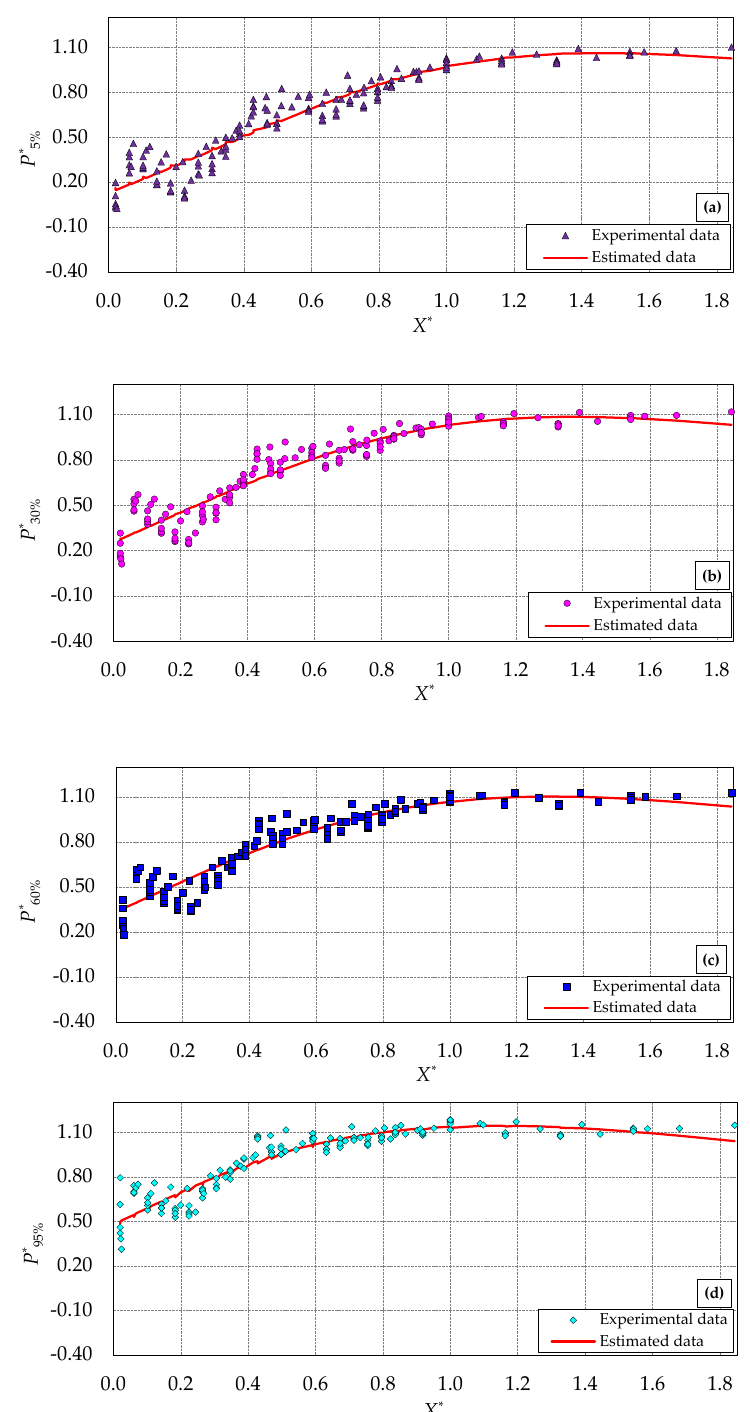
Figure 10. Longitudinal distribution of the experimental and estimated data of P * K% parameter with different probabilities along basin II : ( a ) P * 5% ; ( b ) P * 5% ; ( c ) P * 60% ; ( d ) P * 95% .